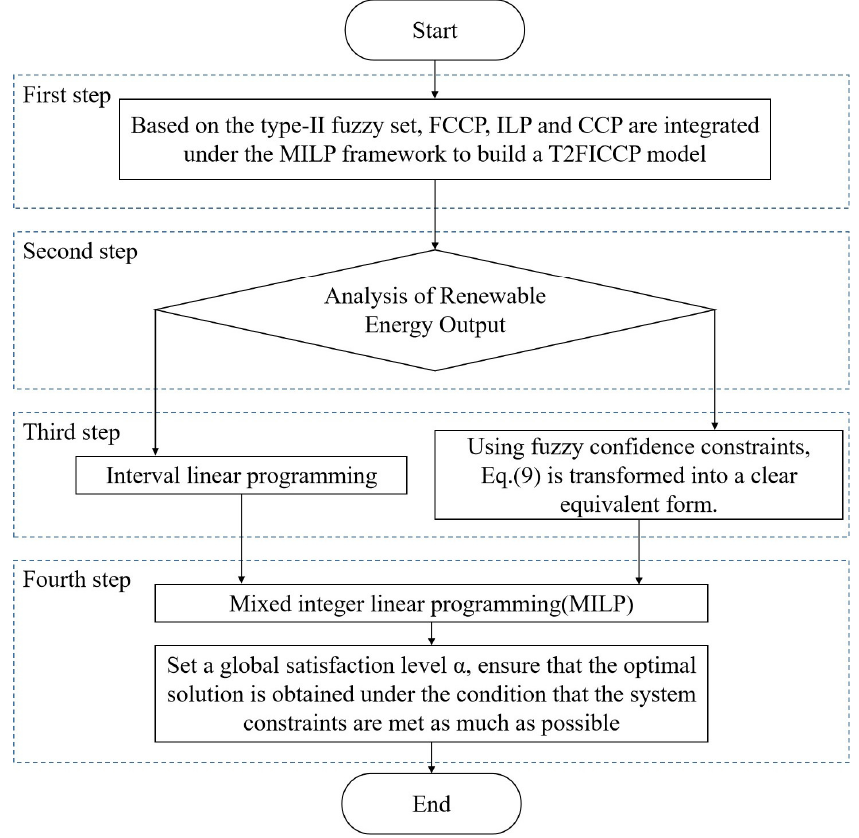
Figure 3. Flow chart of hybrid solution algorithm.